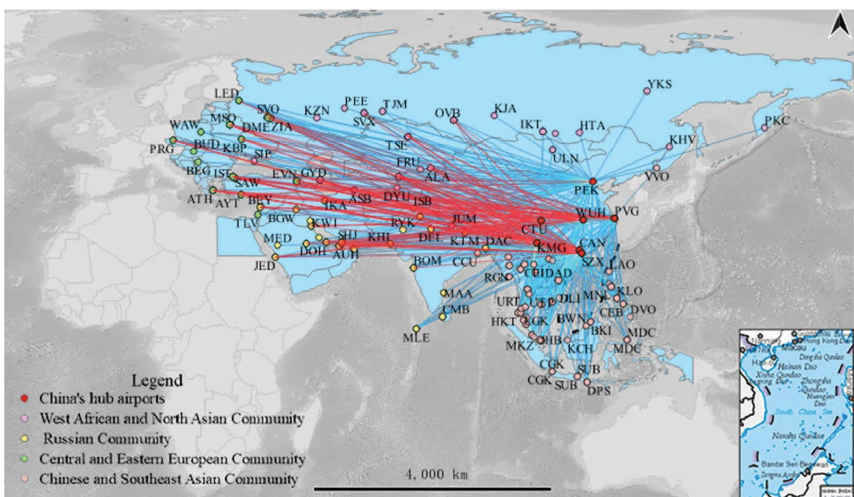
Figure 14: Scheme diagram for deeply integrating into the key node sets of other